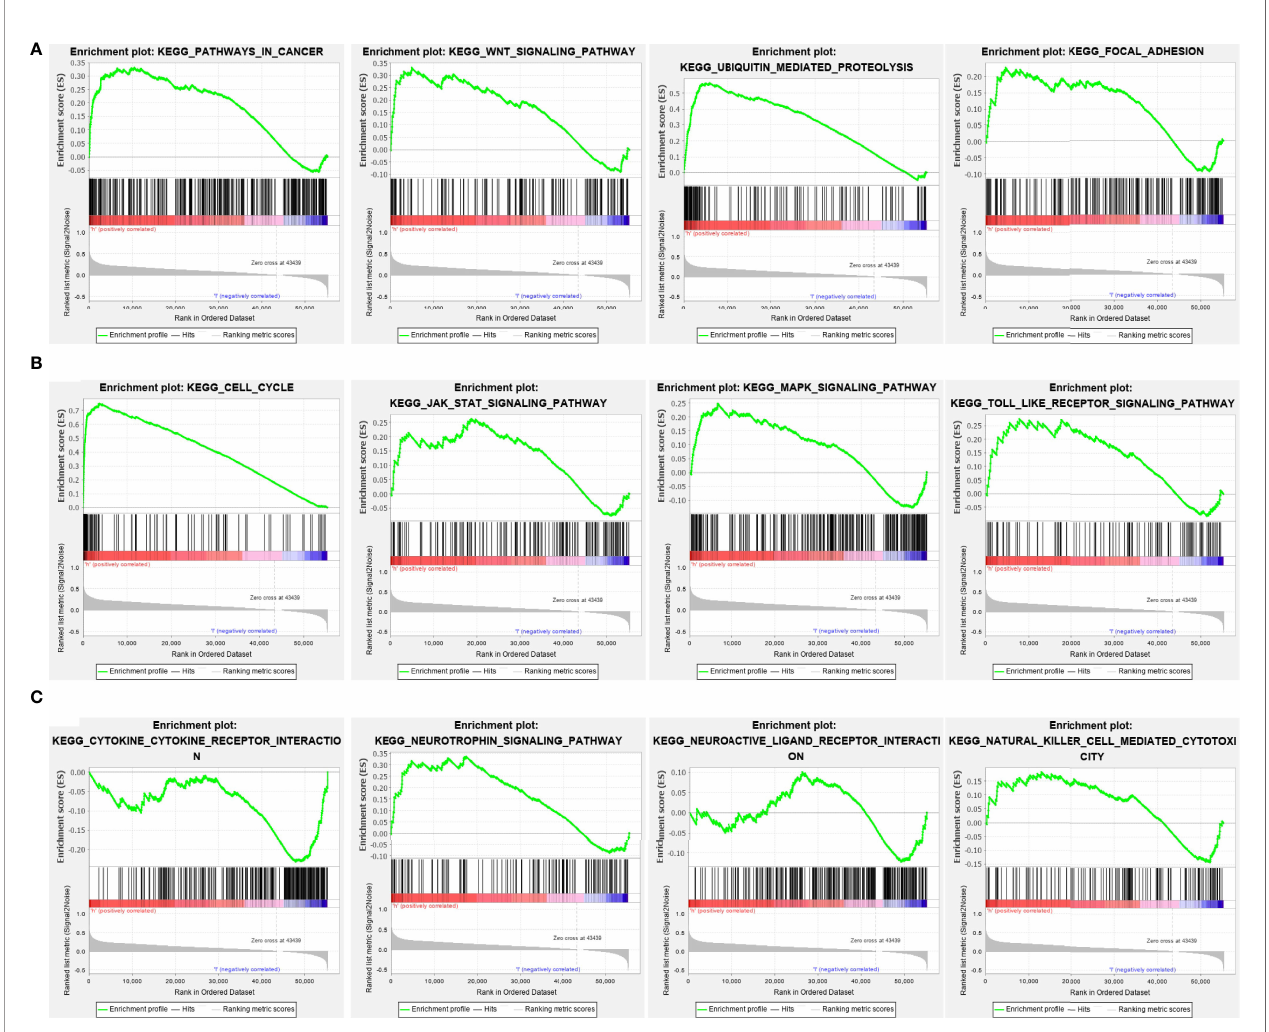
FIGURE 9 | KEGG signaling pathway explore by GSEA software. (A – C) The signaling pathway involved by NCAPG2 in LGG examined by GSEA